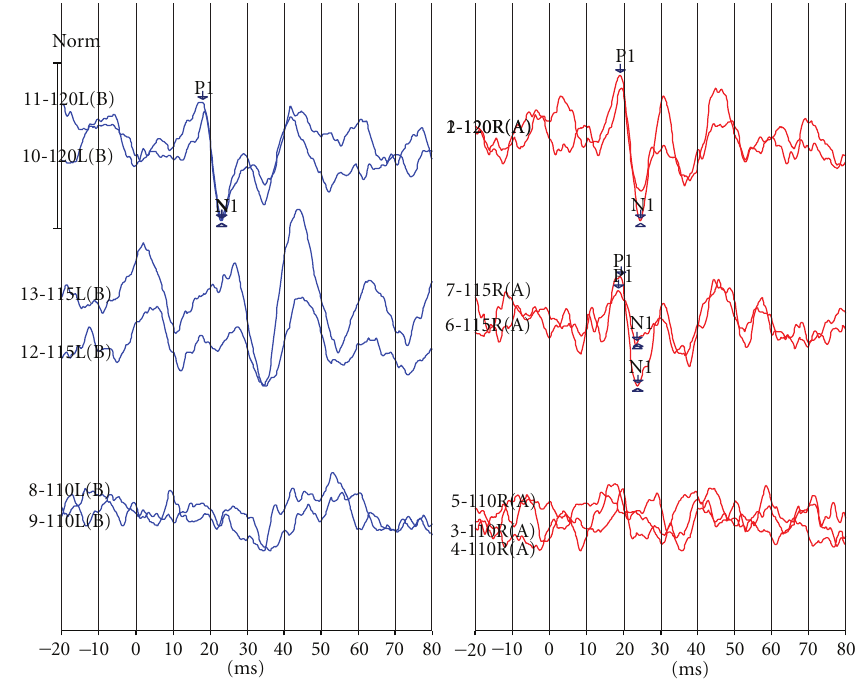
Figure 1: VEMP response waves of the left (threshold = 120dBSPL) and the right ear (threshold = 115